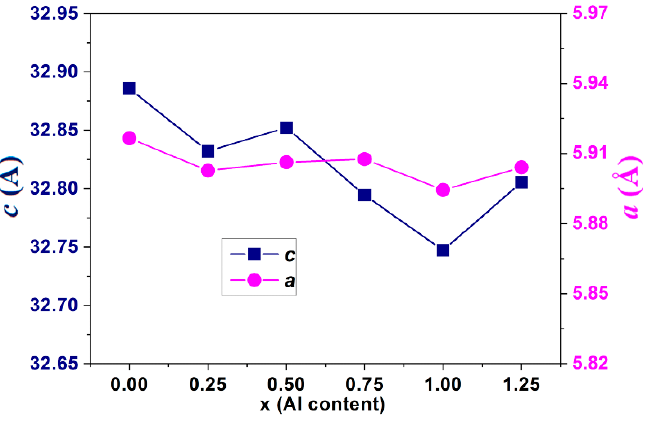
Figure 2. Lattice constants ( c and a ) for the W-type SrYb hexaferrite Sr 0.85 Yb 0.15 Zn 1.5 Co 0.5 Al x Fe 16-x O 27 2. Lattice constants ( c and a ) for the W-type SrYb (0.00 ≤ x ≤ 1.25).